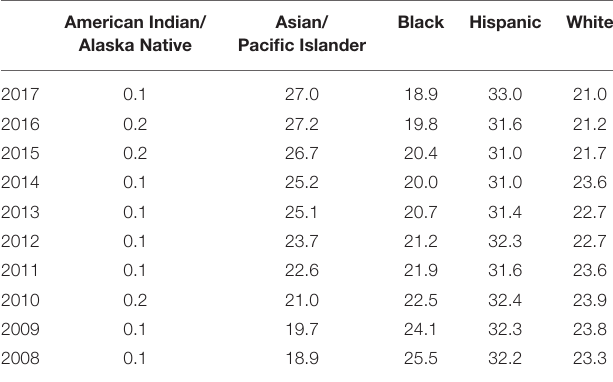
TABLE 4 | Fall enrollment by race at Esmeraldas College (2008-2017). American Indian/ Asian/ Black Hispanic Alaska Native Pacific Islander